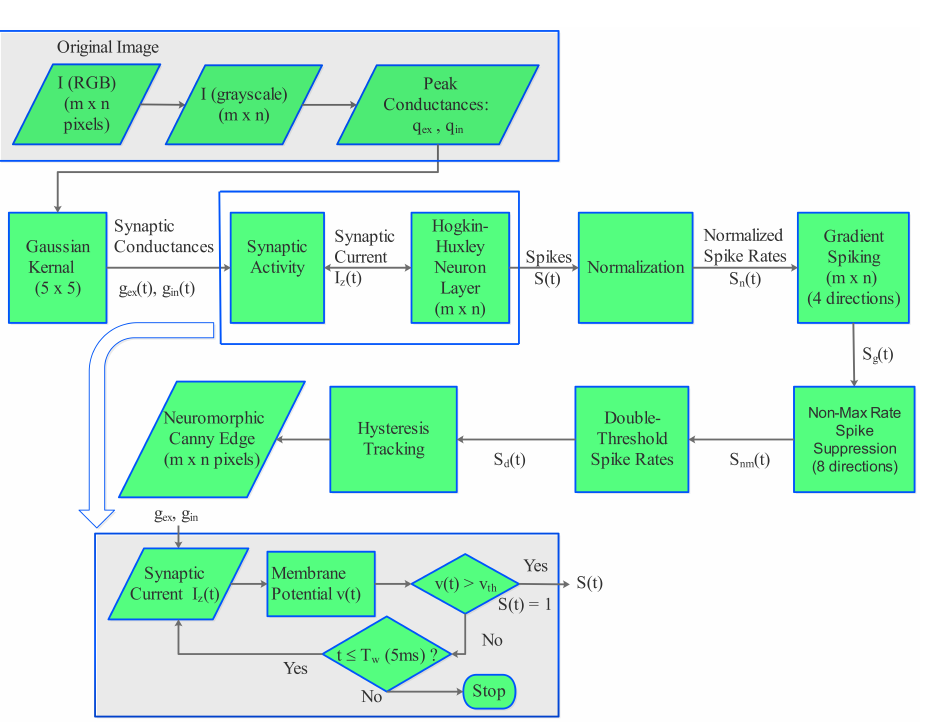
Figure 1. Processing steps in the algorithm for neuromorphic computation of Canny edge detector using conductance-based Hodgkin–Huxley neurons in a neural